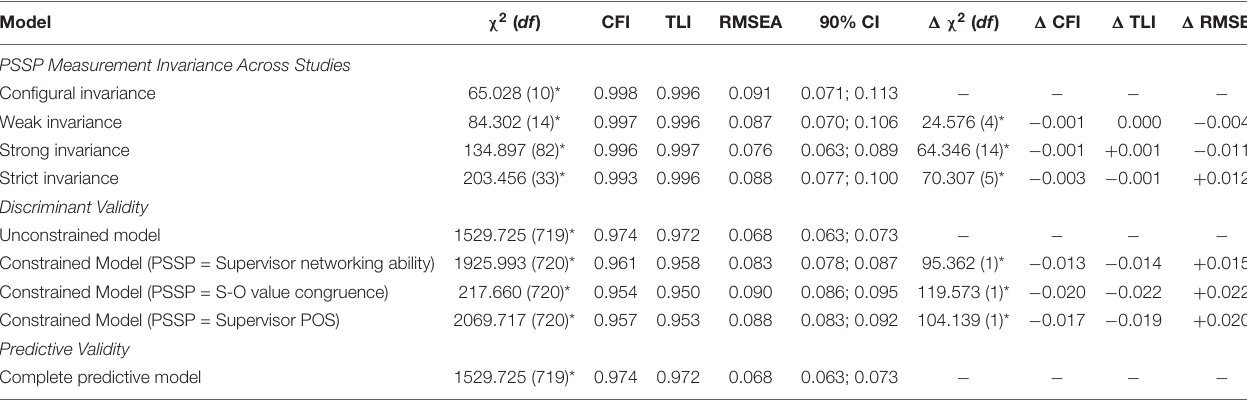
TABLE 7 | Fit Indices for the Models Estimated in Study 3.